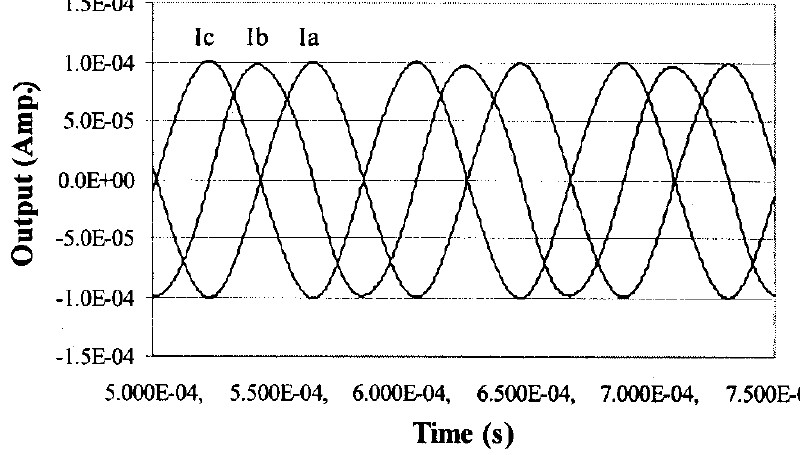
FIGURE 2 Simulation results for the proposed